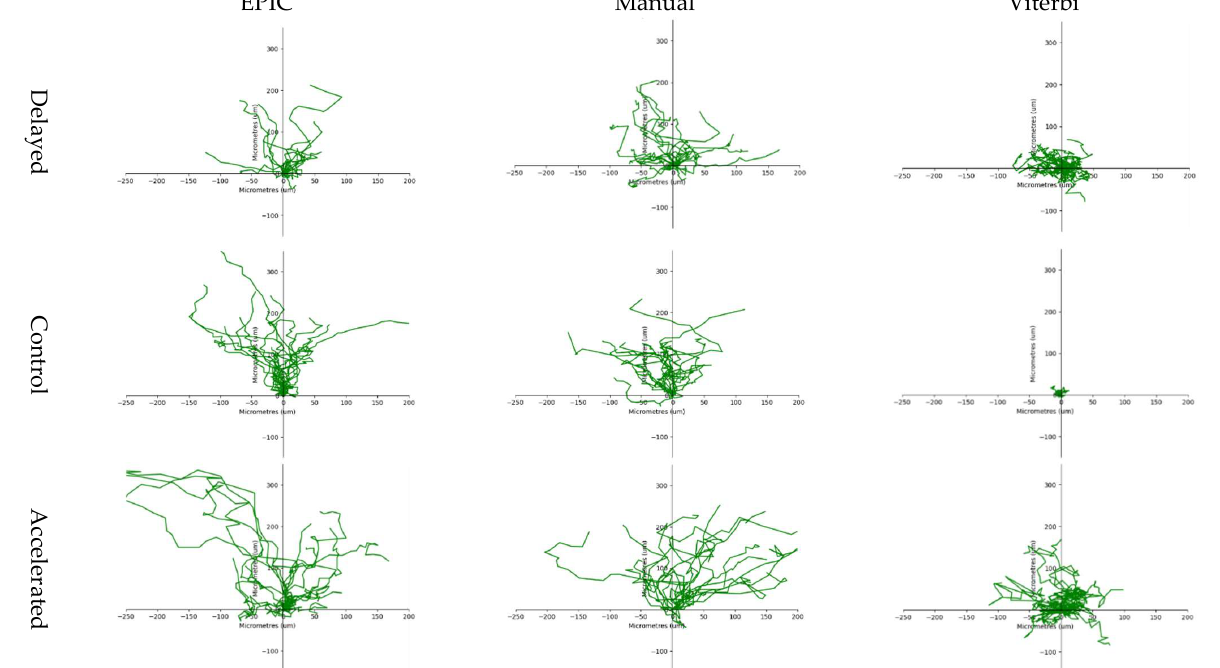
Figure 3. Cell trajectories of the leading edge cells tracked using manual cell tracking, EPIC and Viterbi in a delayed, control and accelerated experiment. Cell trajectories generated using manual cell tracking and EPIC indicate that cells primarily migrated in a positive vertical direction towards the wound region. In contrast, cell trajectories generated using Viterbi do not resemble leading edge cell tracks, instead suggesting that cells moved in more dispersed horizontal and vertical directions, including away from the wound area, contradicting EPIC and manual cell trajectories.